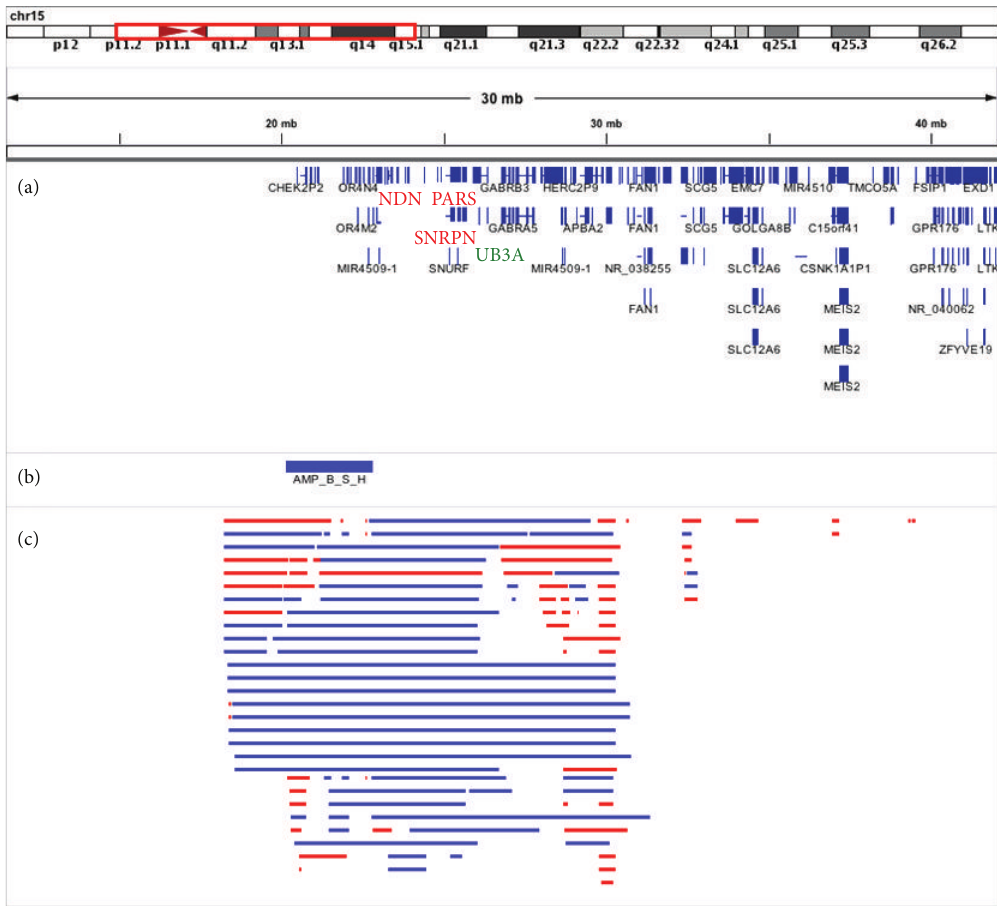
Figure 3: Screenshot of IGV [19] showing the 15q pericentromeric region. (a) Representation of the genes found in the vicinity. Those associated with Prader-Willi/Angelman Syndrome are highlighted in red/green, respectively. (b) Illustration of the duplicated region found in TWO and TWX. (c) Representation of the CNVRs from AUTDB previously associated with ASD (amplifications in blue and deletions in red)